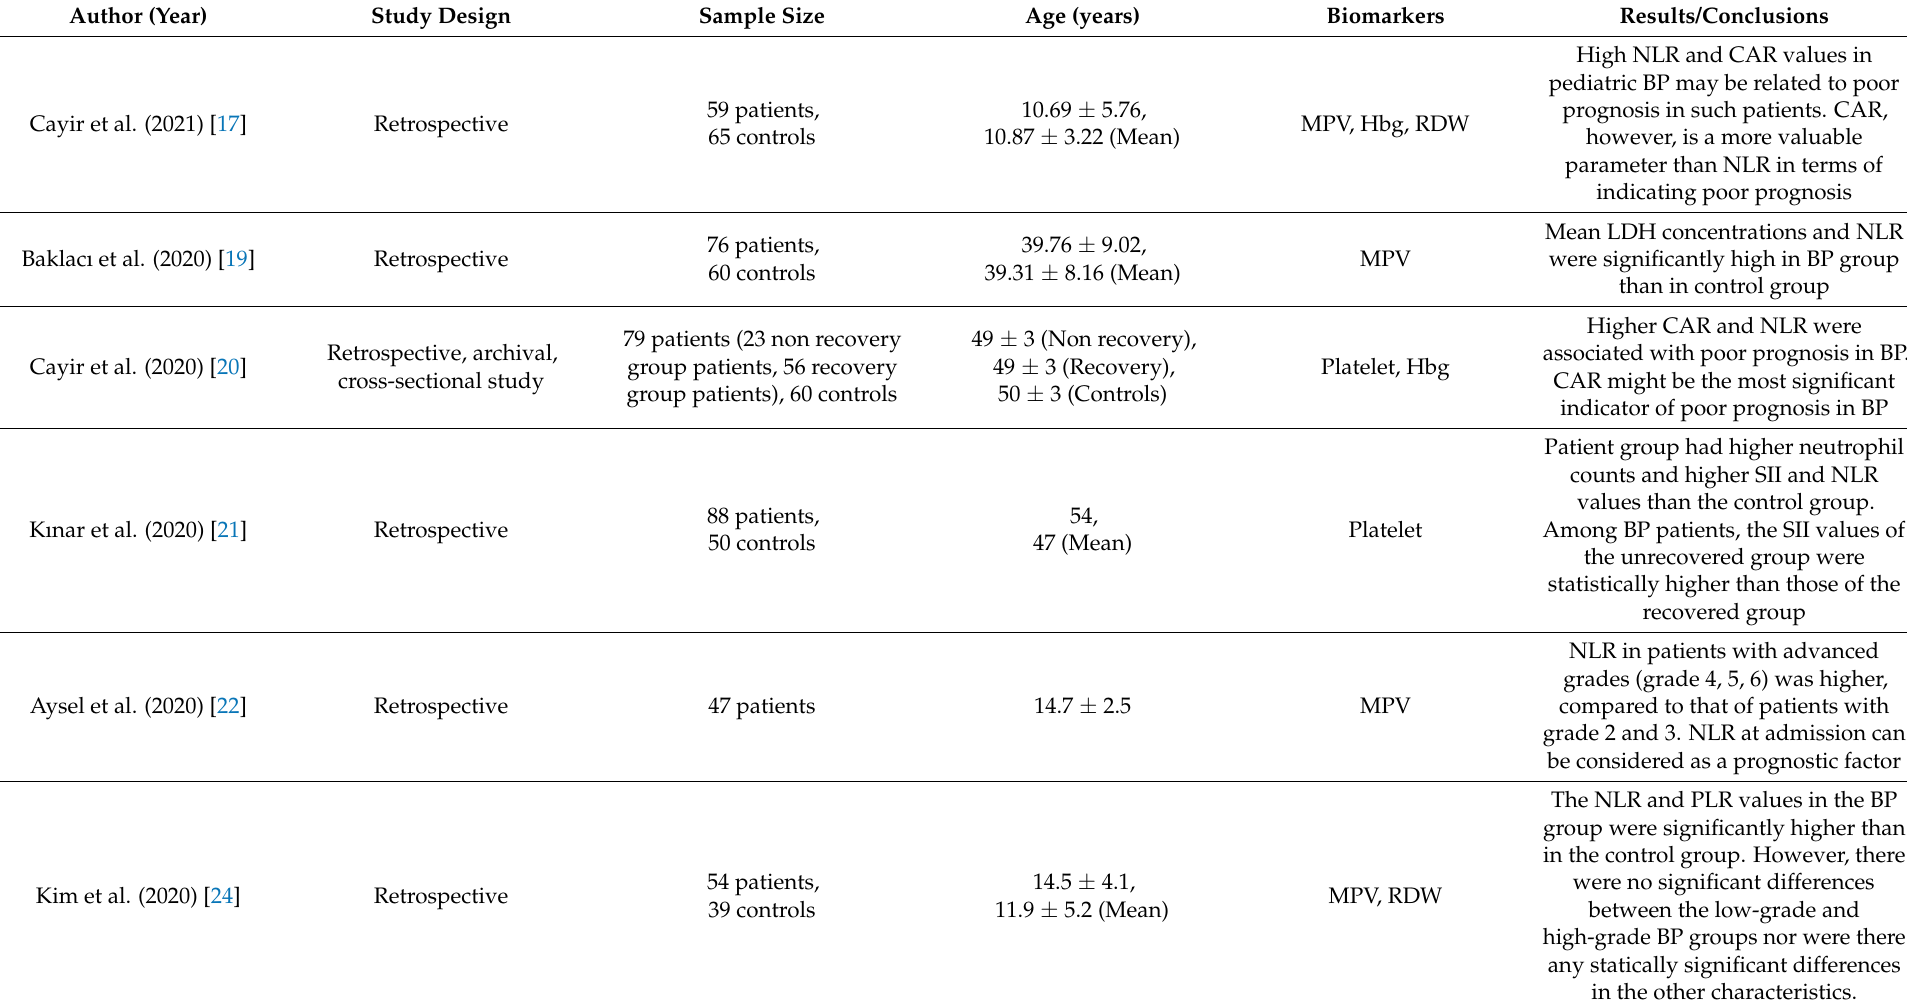
Table 3. Summary of prognostic biomarkers for acute peripheral facial palsy (Hemostatic